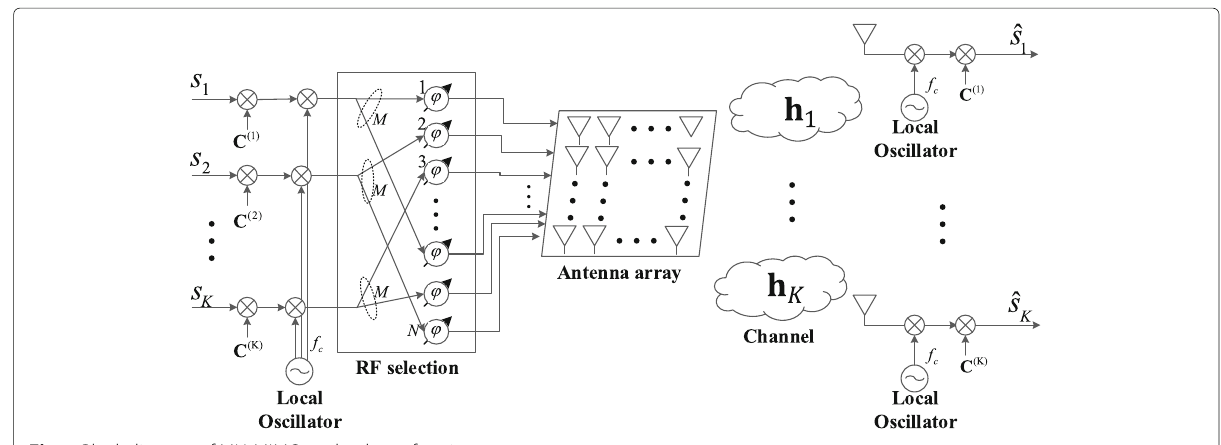
Fig. 1 Block diagram of MU-MIMO analog beamforming